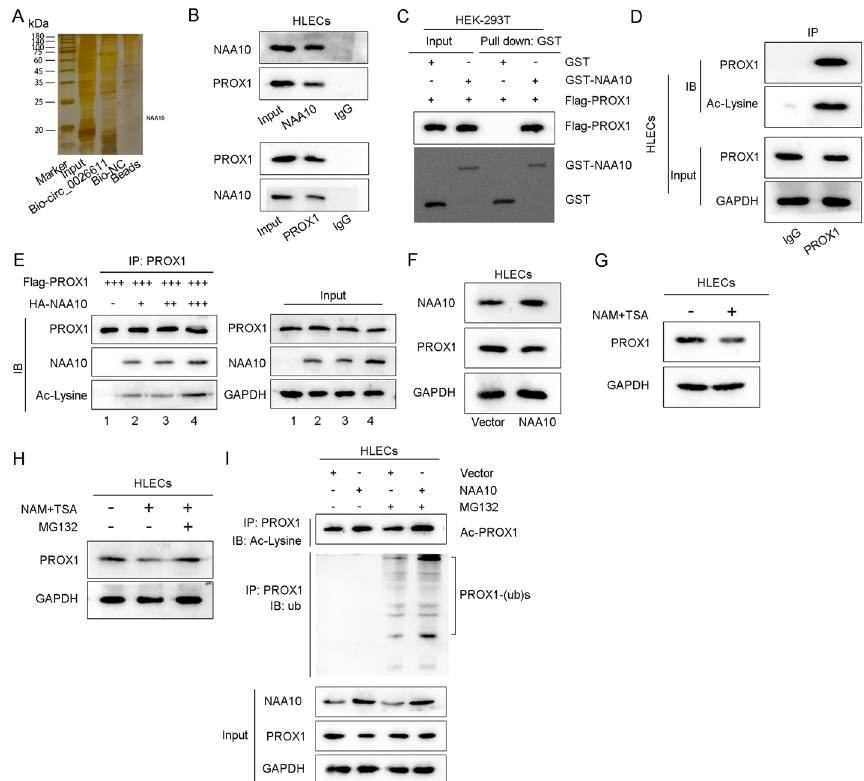
Fig. 5 NAA10 interacting with circ_0026611 mediated PROX1 acetylation and promoted its ubiquitination and subsequent degradation. A The proteins that could interact with circ_0026611 were explored through RNA pulldown as well as mass spectrometry. B CoIP assay verified the interaction between NAA10 and PROX1. C The binding between GST-NAA10 and Flag-PROX1 was detected by GST-pulldown assay. D CoIP was used to detect whether endogenous PROX1 protein could be acetylated. E The effect of NAA10 on PROX1 acetylation was assessed by CoIP assay. F Western blot was used to determine the effect of NAA10 on PROX1 protein. G Western blot was used to assess the effect of NAM TSA on PROX1 protein. H Protein + levels of PROX1 in different treatments. I CoIP assay was used to verify the effect of NAA10 on PROX1 protein acetylation and